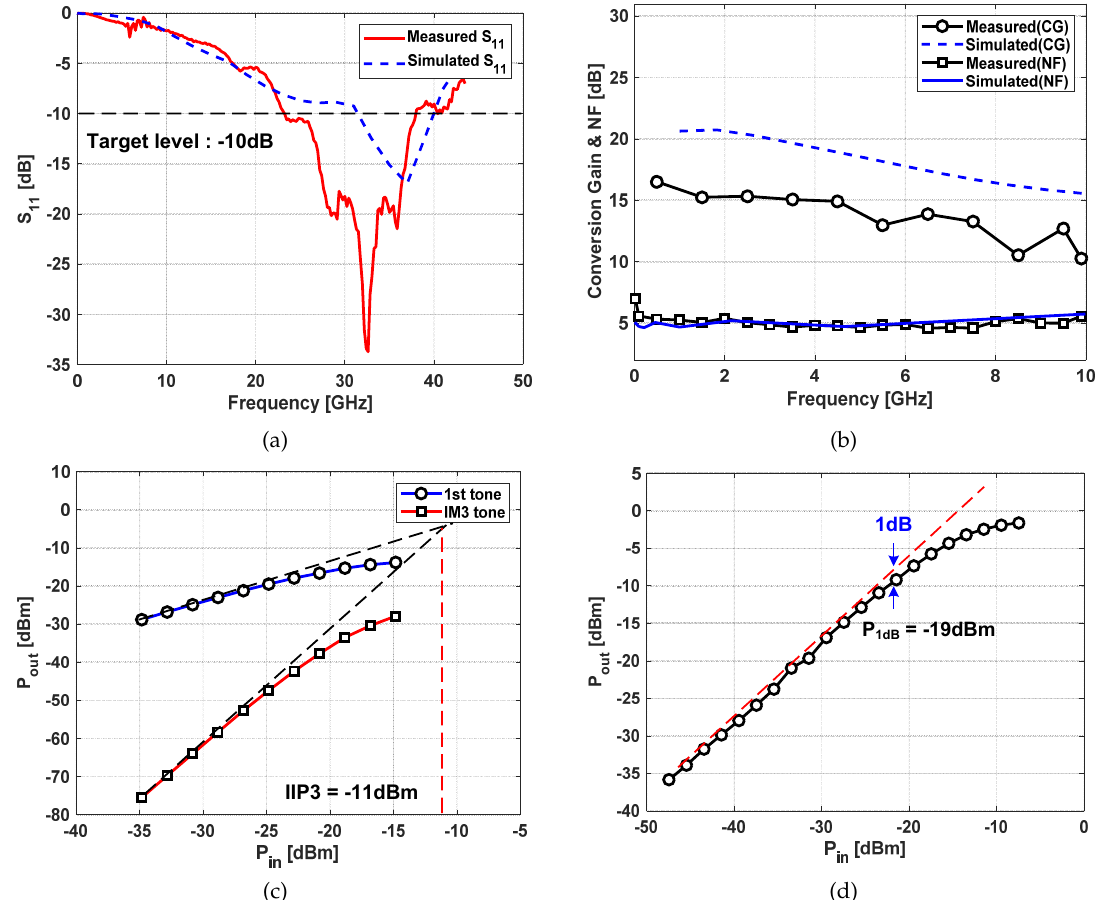
Figure 12. Measured ( a ) input reflection coefficient (S 11 ), ( b ) conversion gain and NF over a 10 GHz IF frequency range; ( c ) IIP3 with frf1 = 35 GHz and frf2 = 35.1 GHz; and ( d ) 1 dB compression point with frf = 35